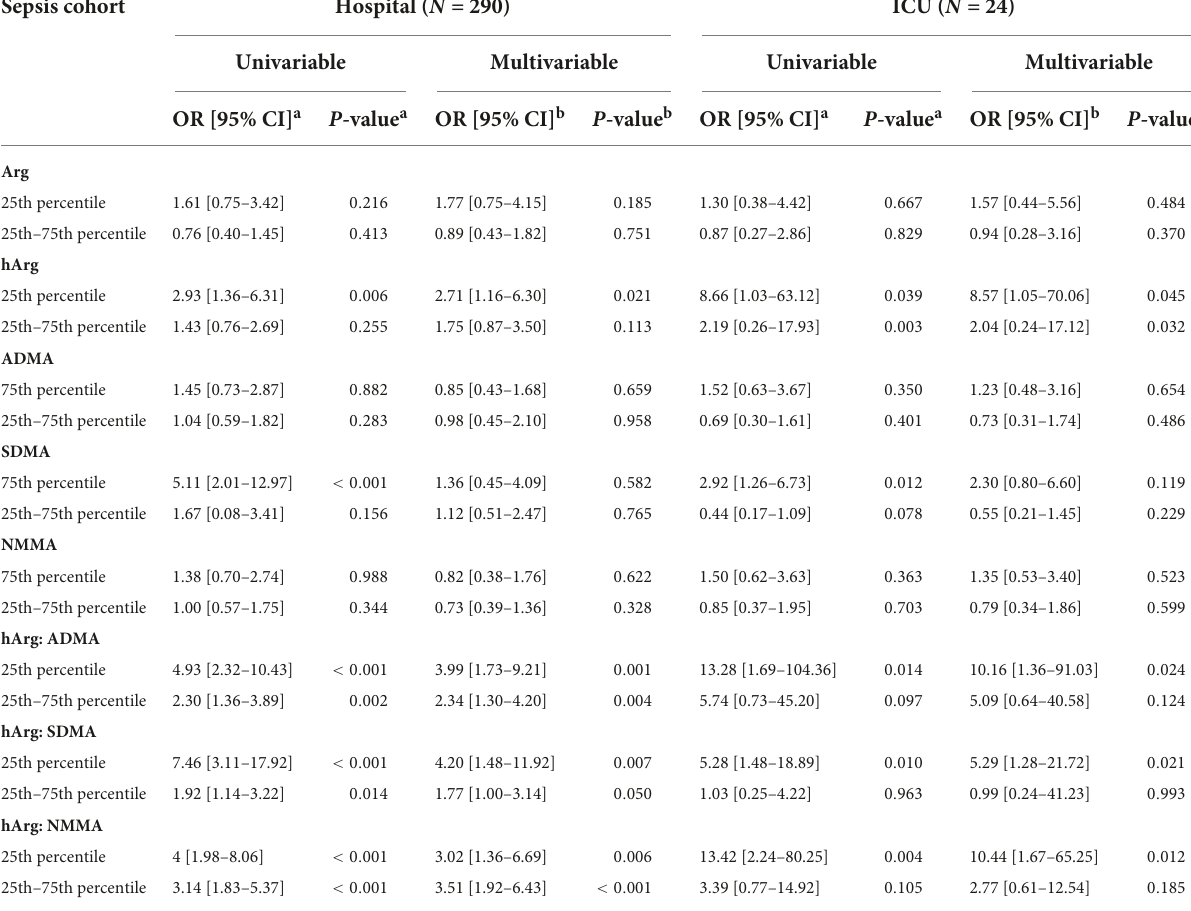
TABLE 2 Independent metabolic predictors of hospital and intensive care unit (ICU) admission. Sepsis cohort Hospital ( N =